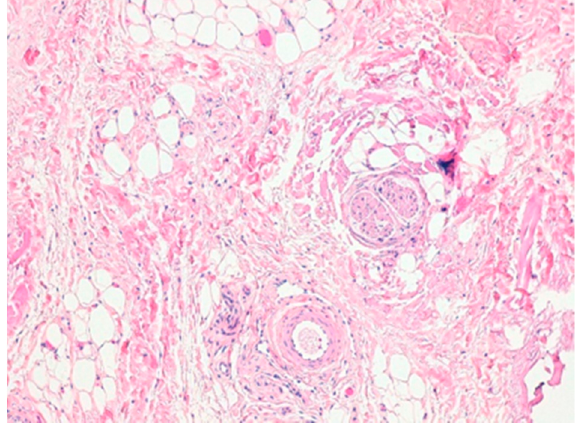
Figure 4. (Hematoxylin-Eosin original magnification 100×). Mixing of fibrous and adipose tissue, blood vessels and nerves.